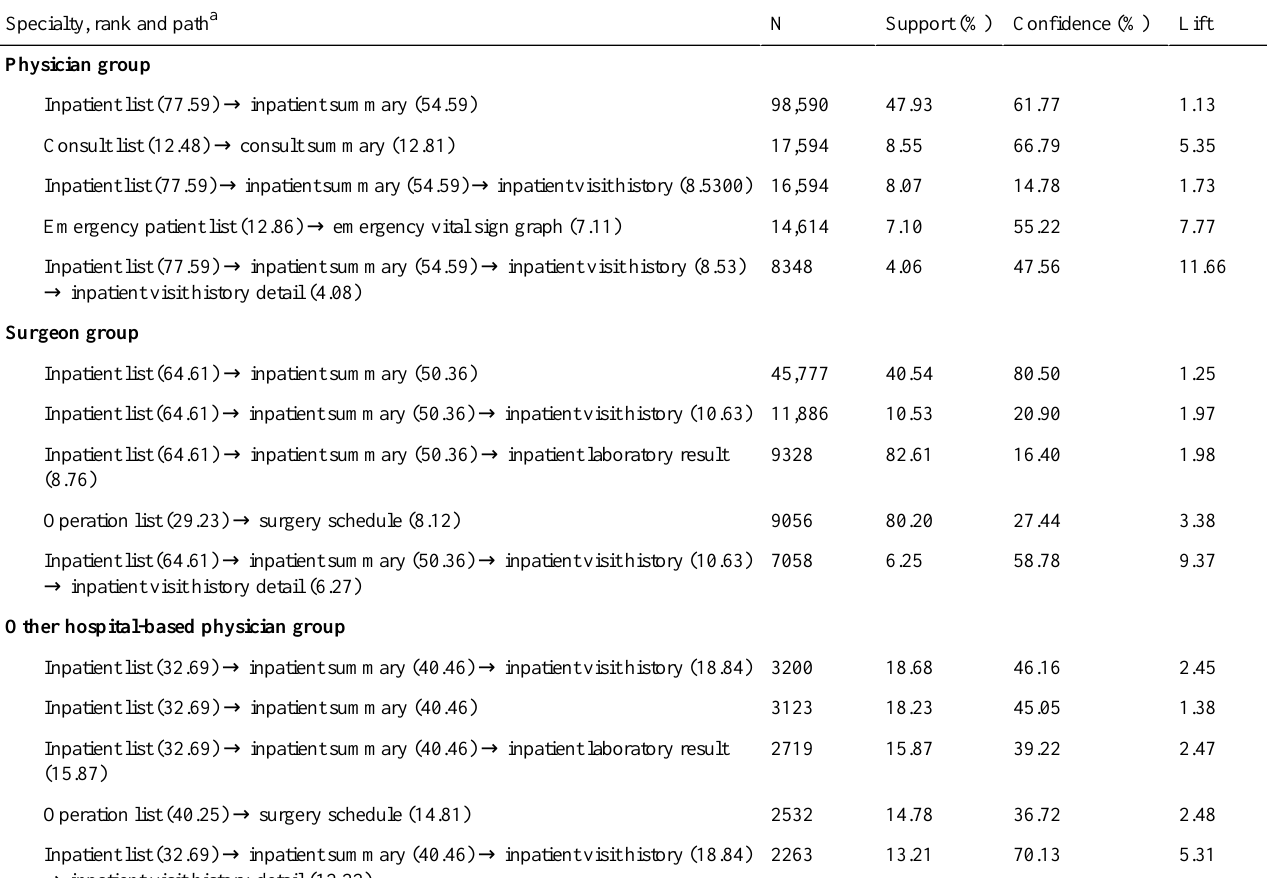
Table 1. Top 5 usage paths identified via association rule mining for each specialty